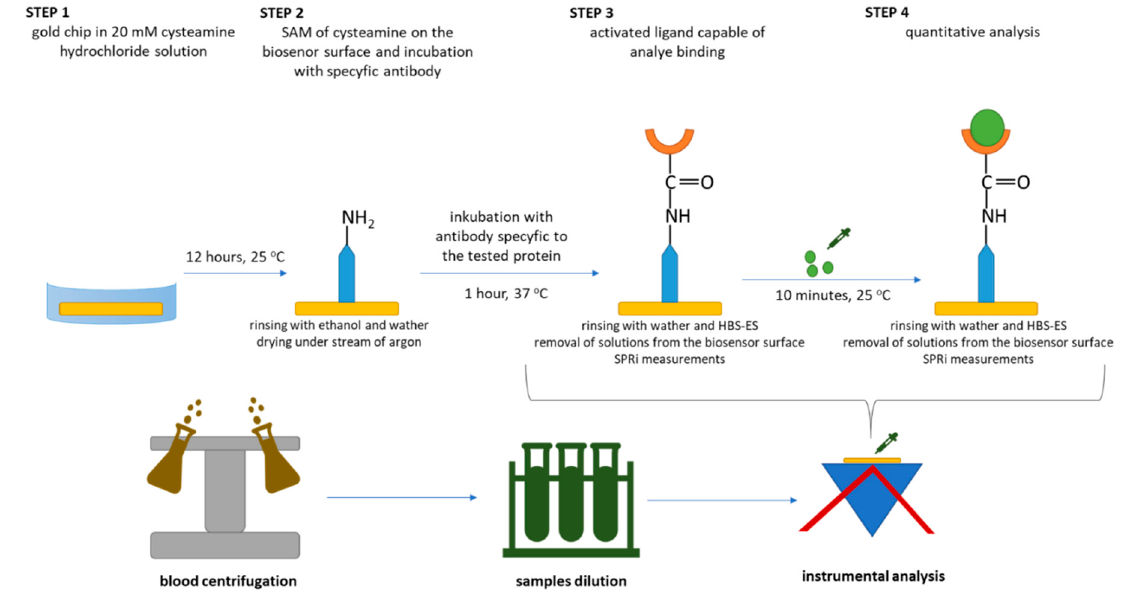
Figure 1. Procedure for quantitative determination of tested proteins.